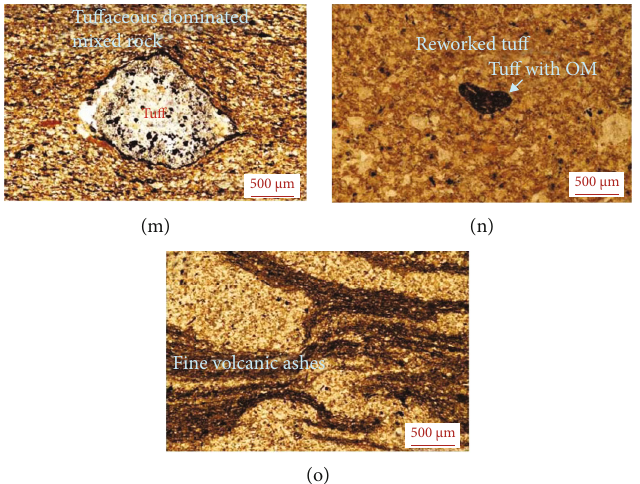
Figure 4: Photomicrographs of the main lithologies in the Lucaogou Formation, Jimusar Sag: (a) well J305, 3409.01m, shell-rich dolomicrite with silts; (b) well J303, 2602.53 m, micrite containing abundant organic matter laminae; (c) well J301, 2779.27m, argillaceous dolomite containing opaque (center) and clean (rim) dolomite, which is recrystallized into a granular texture; (d) well J303, 2595.5m, dolomitic mudstone containing micritic dolomitic laminae; (e) well J305, 3554.54 m, dolomitic mudstone containing higher plant debris; (f) well J43, 2948.5m, dolomite mudstone containing silt and abundant vitrinite (microspores); (g) well J305, 3568.51m, tu ff aceous mudstone with silt laminae; (h) well J251, 3786.61m, dolomitic silty mudstone; (i) well J43, 2948.5m, shale containing silt and organic matter laminations; (j) well J305, 3546.15m, argillaceous siltstone; (k) well J303, 2594.8m, argillaceous marly siltstone; (l) well J43, 2950.5m, argillaceous siltstone (cross-polarized light); (m) well J303, 2576m, dolomitic tu ff ; (n) well J305, 3546.15m, tu ff ; (o) well J305, 3560.54m, intermittent laminated tu ffi